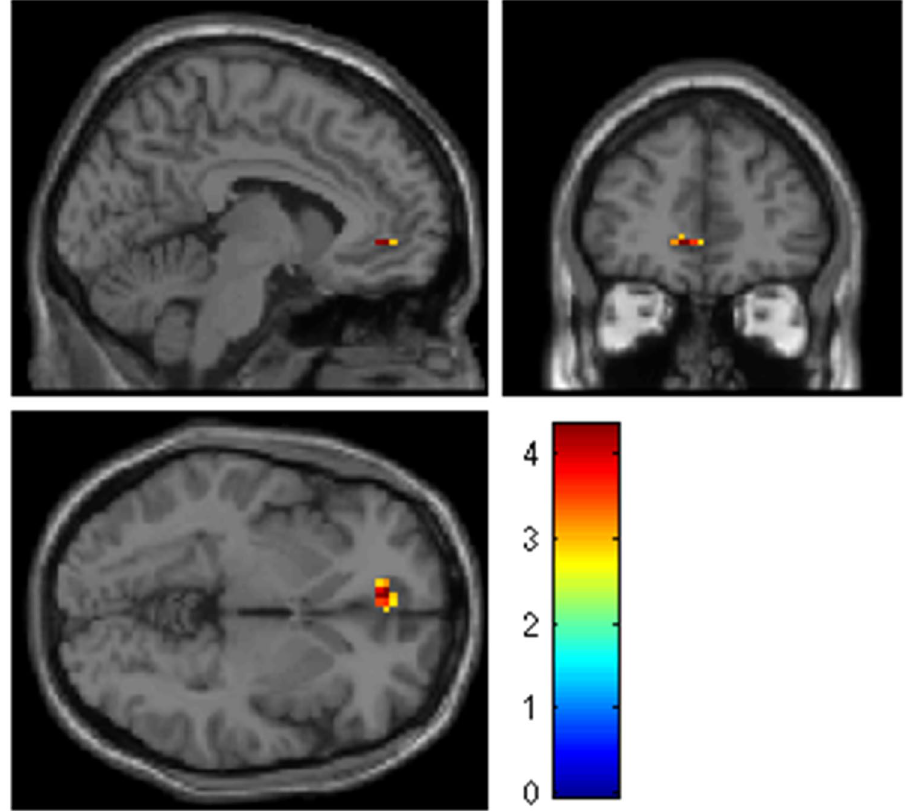
Figure 1. During anticipation of negative emotional stimuli, a higher reactivity was observed in the ACC at the early postpartum assessment than at the late postpartum assessment. The color bar indicates the T -scores.